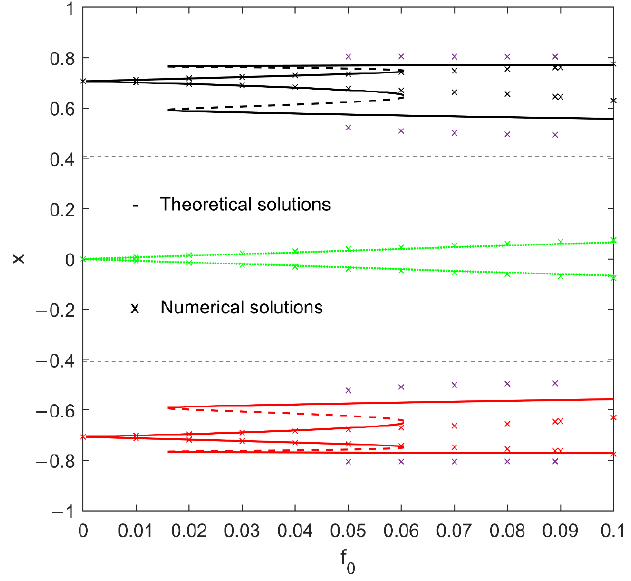
Figure 6. Variation of the periodic solutions with the amplitude of f 0 when ω = 1.5. Fixing ω = 1.5, the evolution of periodic responses and their basins of attraction with the increase of the dimensionless excitation amplitude f 0 is shown in Figure 7. For f 0 = 0, the coexisting triple attractors are the three well centers whose basin boundaries are smooth, as shown in Figure 7(a1,a2). For f 0 = 0.045, the three point attractors are perturbed and replaced by three intra-well periodic attractors around them (see Figure 7(b1)). Although the single-colored neighborhood of each well center in Figure 7(b2) implies that the initial conditions chosen there must attract to the intra-well attractor around it, the inter-well jump may be triggered when the initial conditions are disturbed dramatically. As f 0 increases a bit to reach 0.046, two new intra-well periodic attractors with higher amplitudes suddenly appear in the neighborhood of the nontrivial well centers. As predicted in Figure 6, this can be attributed to the saddle-node bifurcation. Now, there are five intra-well attractors in Figure 7(c1). However, as shown in Figure 4(c2), the basins of attraction of the new attractors are fractal and scattered. Thus, the occurring probability for these two high-amplitude intra-well responses is very low. As f 0 continues to increase, the basins of attraction of the two new periodic attractors are enlarged (see Figure 7(d2)). It means that the occurrence probability of the higher- amplitude intra-well attractors around the well centers C − and C + is much higher. Moreover, the jump between the two intra-well attractors around each nontrivial well center, namely the intra-well jump, is of higher probability to occur. Therefore, not only the intra-well jump due to saddle-node bifurcation of the periodic solution around the nontrivial well centers and a small perturbation of the initial condition but also the inter-well jump among attractors around different wells that is led by dramatic disturbance of the initial condition can make the structure harvest vibration energy more